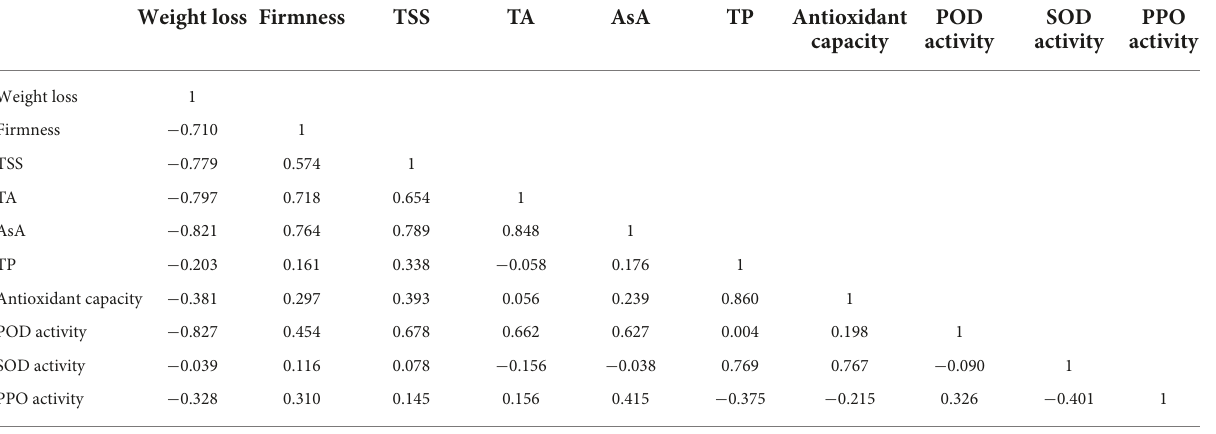
TABLE 3 Pearson’s correlation coefficients between some selected quality factors of fresh-cut pitaya fruit during storage.